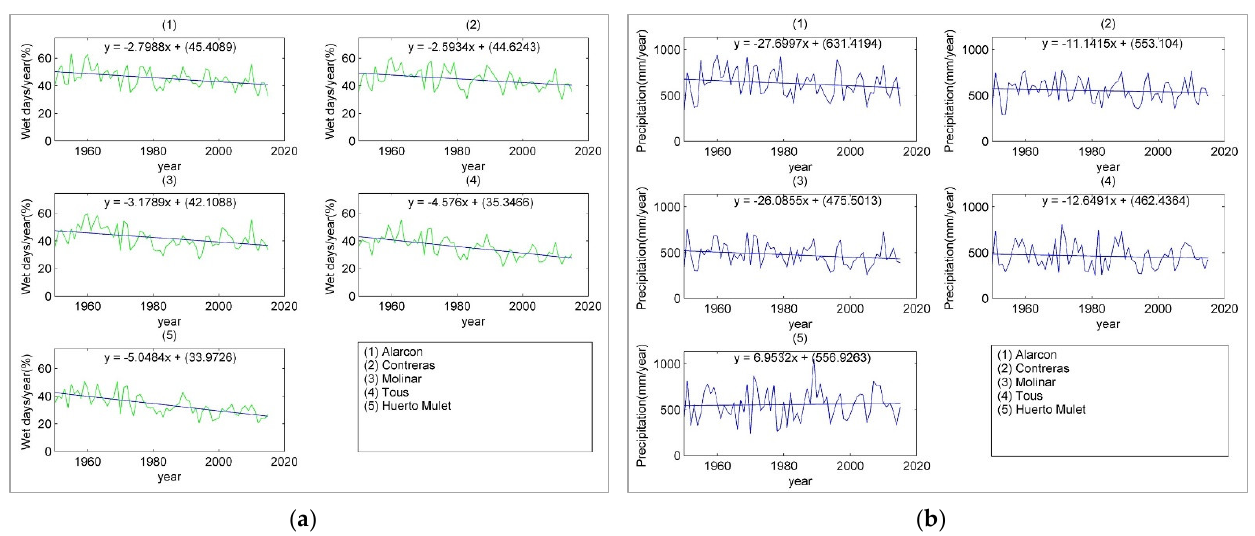
Figure A4. Interannual variation trends of the average ( a ) precipitation occurrence (wet days year −1 ) and ( b ) rainfall (mm year −1 ).